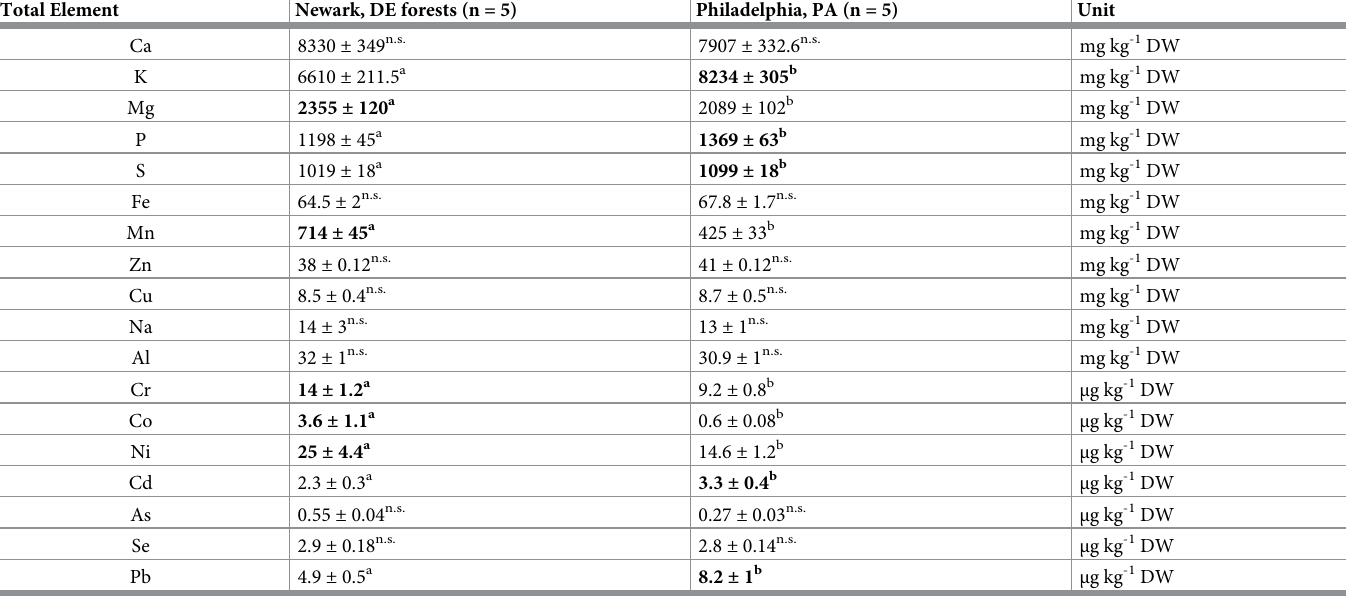
Table 2. Concentrations of total foliar elements in red maples from five forests each in Newark, DE (n = 39) and Philadelphia, PA (n = 38). Total Element Newark, DE forests (n = 5) Philadelphia, PA (n = 5) Unit 8330 ± 349 n.s. 7907 ± 332.6